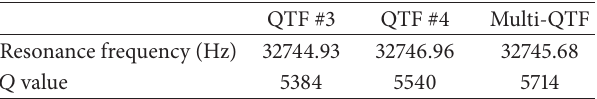
Figure 6: Resonance curves obtained for QTF #1, QTF #2, and Multi-QTF using the configuration of Figure 4(c). Table 2: Parameters of multi-QTF based “on-beam” spectrophone (Figure